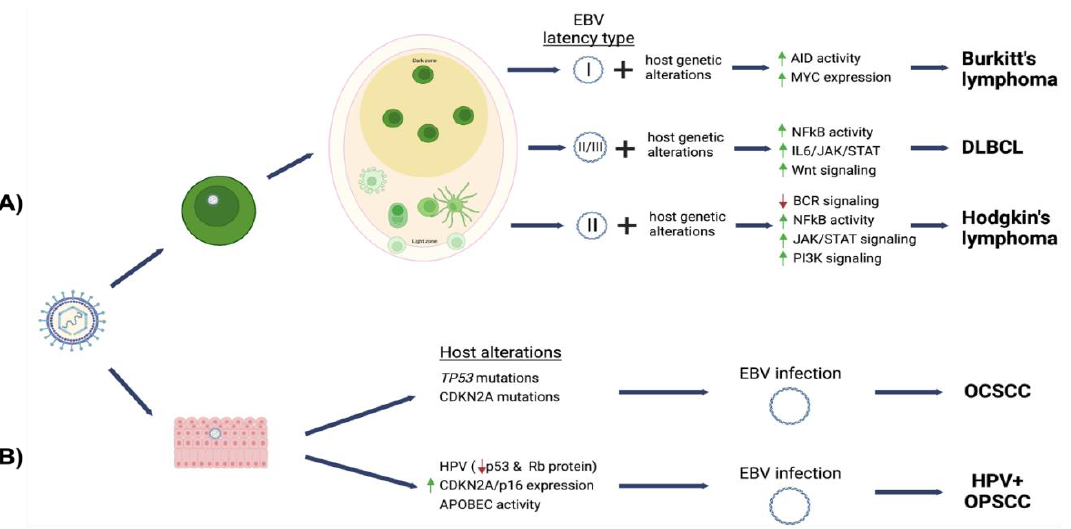
Figure 2. Models summarizing the contribution of EBV in oral cancers. ( A ) EBV Infected B cells circulate to secondary lymphoid tissues where viral latent gene products promote clonal expansion and germinal center survival and differentiation into centroblasts. Tumors may arise from cells participating in GC (BL) reactions or post-GC selection (cHL, DLBCL NOS). The viral latency program complements acquired host mutations and influences the outgrowth of the tumor cell. In BL, EBV infection can induce AID which can increase genomic instability. AID overexpression can induce MYC chromosomal translocations into the immunoglobulin enhancer region leading to MYC overexpression. EBNA 1 has been suggested to interfere with p53 to prevent MYC induced apoptosis. In DLBCL, EBV-positive tumors tend to have a lower frequency of mutations that EBV-negative types. Recurrent mutations activate NF-kB/JAK-STAT/Wnt signaling pathways. In HL, EBV may support growth and survival following loss of B cell receptor signaling (BCR), with constitutive activation of NF-kB, and JAK/STAT signaling pathways conferring resistance to apoptosis. EBV LMP1 induces pathways activated in HL and EBV + DLBCL. ( B ) The oral epithelium supports the EBV productive lifecycle. Genetic changes that interrupt EBV productive replication and/or facilitate EBV latent infection have been linked to development of OSCC. In oral cavity squamous cell carcinomas (OCSCC), mutations in TP53 and CDKN2A are drivers of OCSCC tumor progression. EBV infection likely occurs at a later stage where additional genetic and epigenetic alterations allow for long term latent infection. EBV infection and expression of latent gene products can influence cell growth, survival, migration, and differentiation. The majority of oropharyngeal squamous cell are due to HPV infection. Expression of the HPV oncogenes E6 and E7 facilitates the degradation of p53 and the retinoblastoma family of pocket proteins, respectively. Presence of HPV induces APOBEC and genomic instability that contributes to the evolution of the tumor cells. HPV-immortalization due to E7 expression interferes with EBV productive replication that result in abortive or latent infections. Increased persistence of EBV and expression of EBV gene products in HPV-immortalized cells may contribute to the rapid progression observed for HPV-positive OPSCC. Image was created with BioRender.